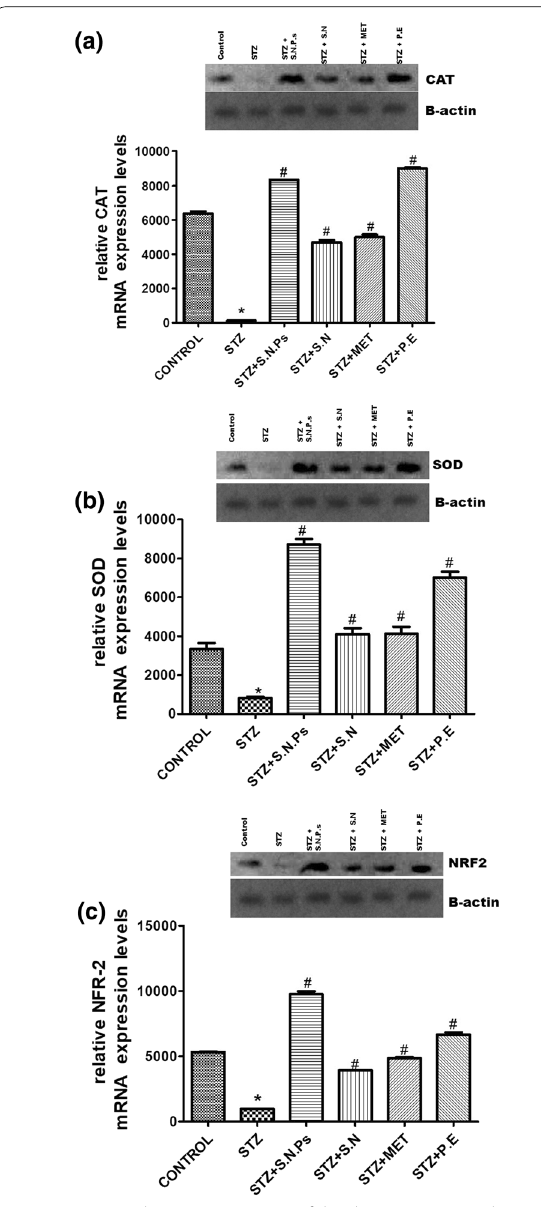
Fig. 8 a A snapshot representation of the densitometric evaluation of agarose gel electrophoresis of the RT-PCR analysis of CAT gene expression. * represents statistical difference to control ( p < 0.05) while # represents statistical difference to diabetic control ( p < 0.05). b A snapshot representation of the densitometric evaluation of agarose gel electrophoresis of the RT-PCR analysis of SOD gene expression. * represents statistical difference to control ( p < 0.05) while # represents statistical difference to diabetic control ( p < 0.05). c A snapshot representation of the densitometric evaluation of agarose gel electrophoresis of the RT-PCR analysis of NRF2 gene expression. * represents statistical difference to control ( p < 0.05) while # represents statistical difference to diabetic control ( p < 0.05)